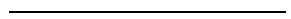
Table 4 Amount of hydrogen release from different compositions of